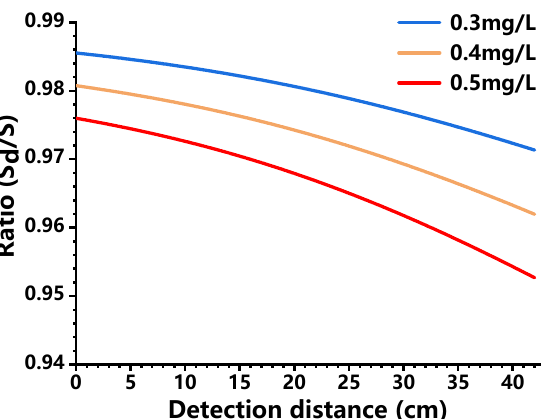
Figure 6. Ratio as a function of detection distance at three different concentrations (0.3 mg/L, 0.4 mg/L, 0.5 mg/L).